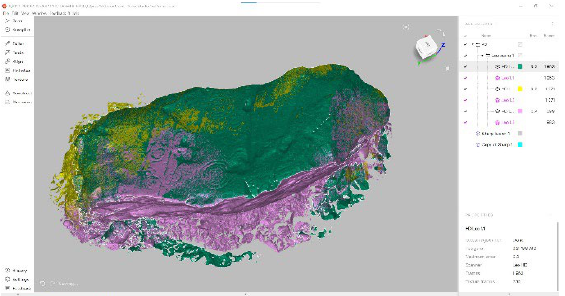
Figure 10. A screen capture of the scan data in Artec Studio 16.